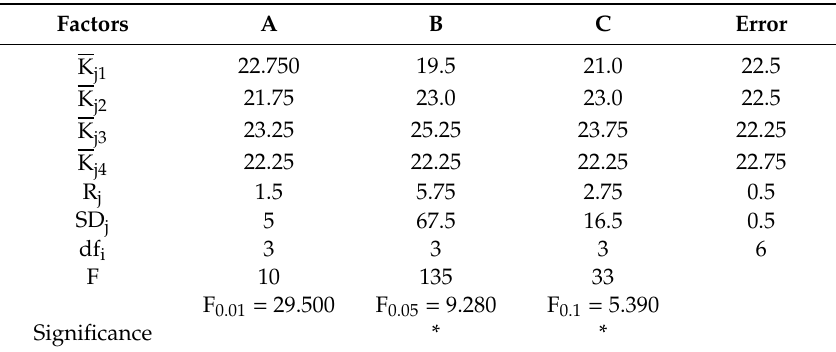
Table 6. Range analysis for interfacial shear